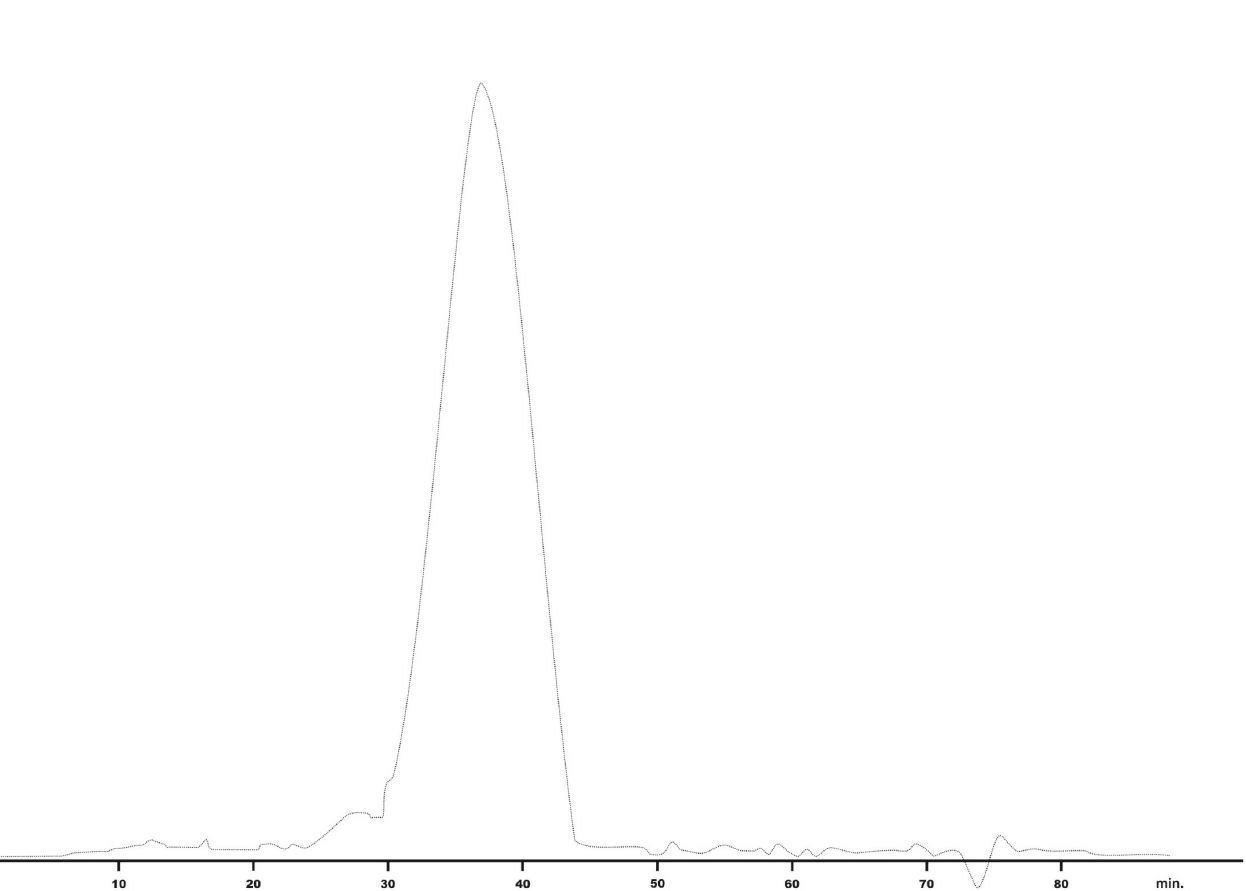
FIGURE 2 - Chromatogram showing the absence of aggregates and a monomer area main peak of 99.5%.